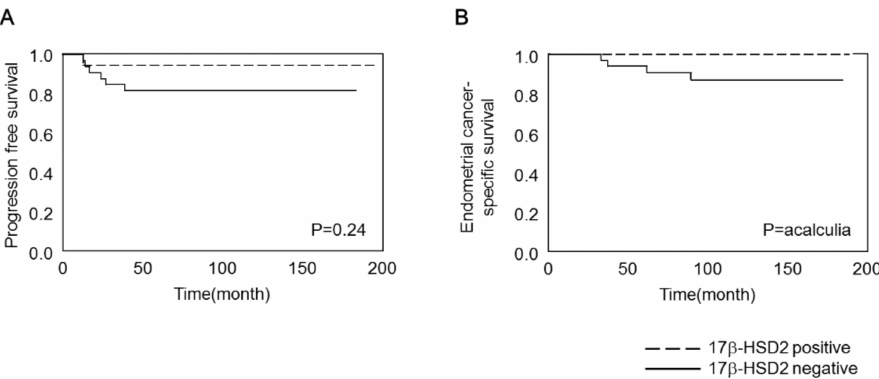
Figure 5. Correlation between 17 β -HSD2 status and progression-free survival ( A ) or endometrial cancer-specific survival ( B ) for 53 patients with endometrioid endometrial adenocarcinoma. 17 β -HSD2 status was evaluated via immunohistochemistry, and immunoreactivity greater than 50% was considered positive. Dates were compared statistically using the log-rank test. p < 0.05 was considered significant. The median value of 17 β -HSD2 score was as follows: total, 40 ± 20.30 (range 0–70%); positive group, 50 ± 6.97 (range 50–70%); negative group, 20 ± 14.45 (range